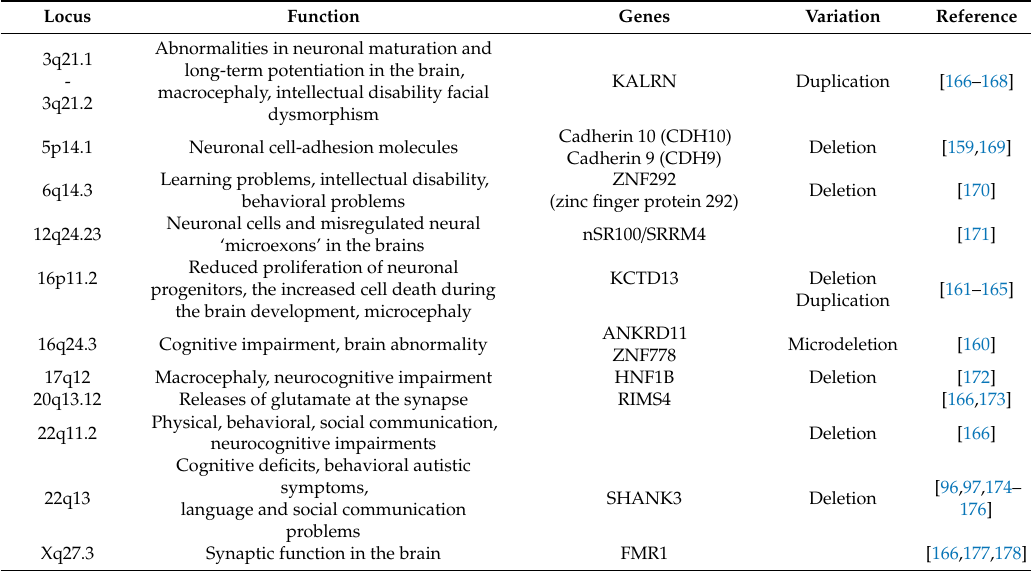
Table 1. Chromosome locus associated with